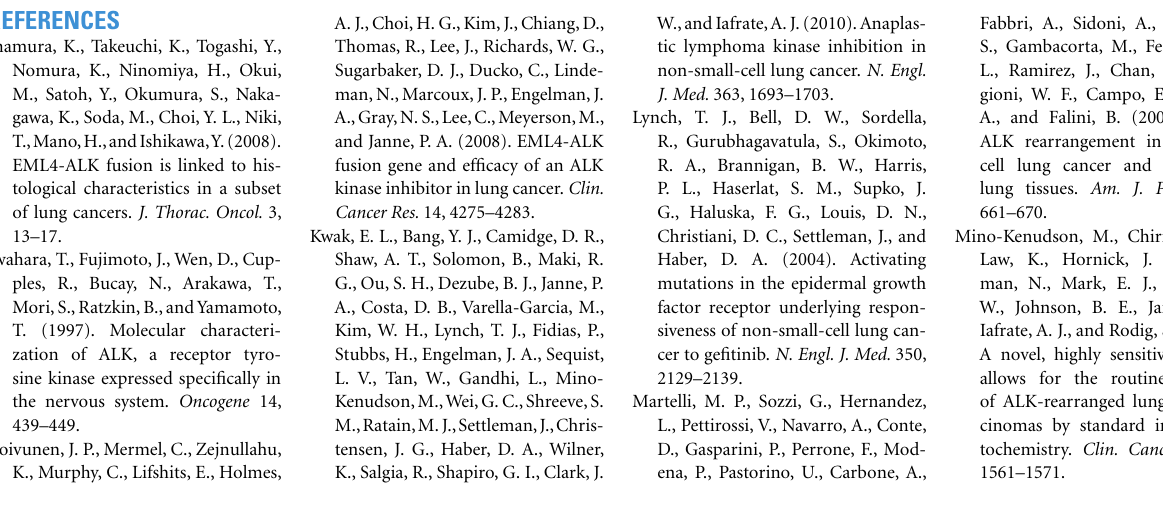
FIGURE 8 | Diagnostic algorithm forALK fusion from the Japanese Lung Cancer Society. The standard procedure for formalin-fixed paraffin embedded specimens involves screening with immunohistochemistry and confirmation with FISH. Even when the ALK immunohistochemistry is negative, FISH is recommended for the patients who are suspected of harboring the ALK fusion based on clinical considerations (age lower than 40years, for example), and morphology (e.g., a mucinous cribriform